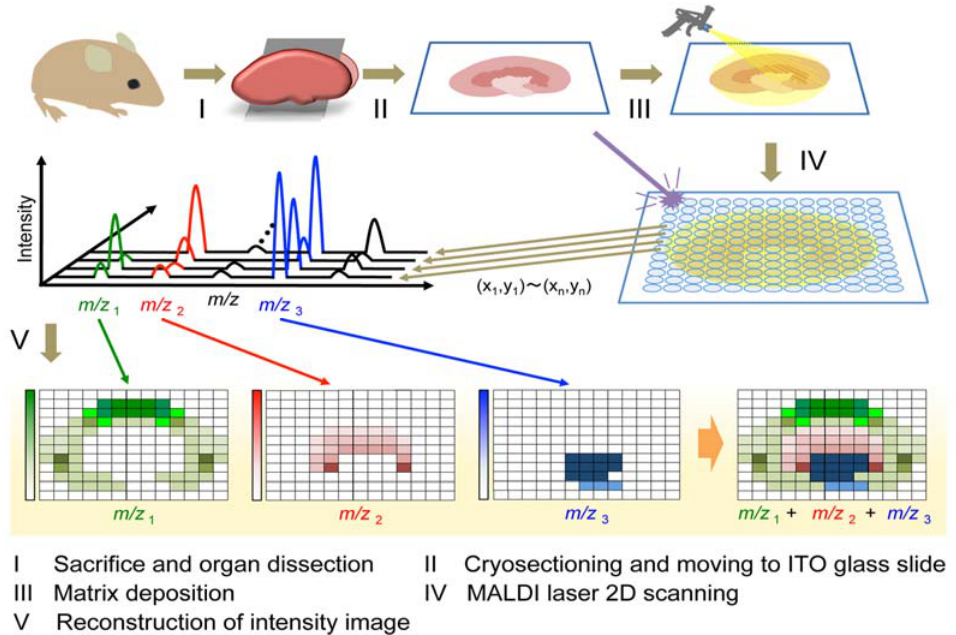
Figure 2. The schematic representation of MALDI-MSI experimental